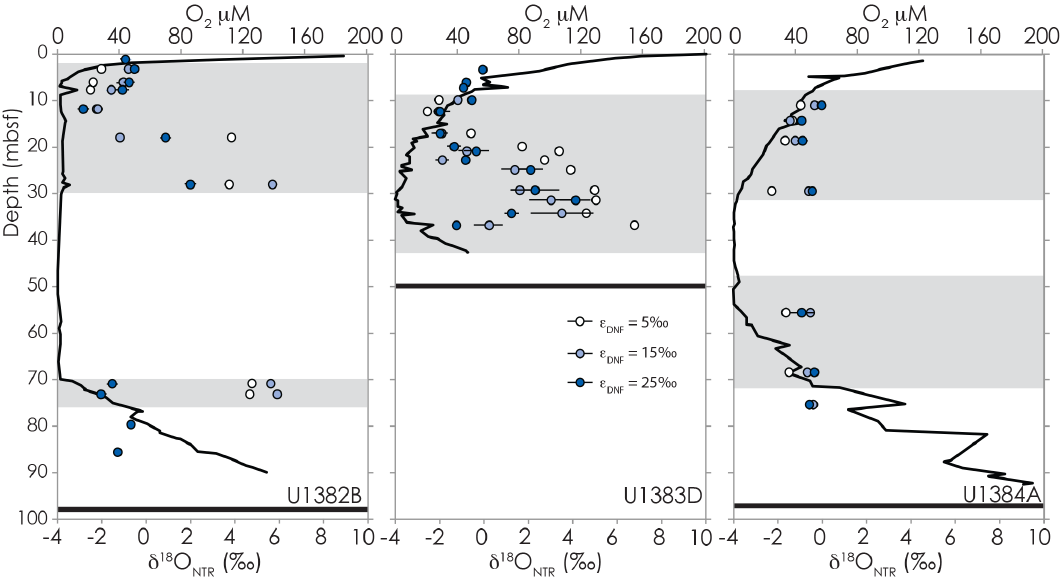
Figure 6. Model-estimated values for the O isotopic composition of new nitrate produced by nitrification ( δ 18 O NTR ) occurring within porewaters. Values are calculated for depths at which O 2 concentrations were >2µM (e.g., oxic and transitional intervals). Sensitivity of δ 18 O NTR to prescribed values of the isotope effect for denitrification ( 15 ε DNF ) in transitional intervals, where both nitrification and denitrification can co-occur, is also